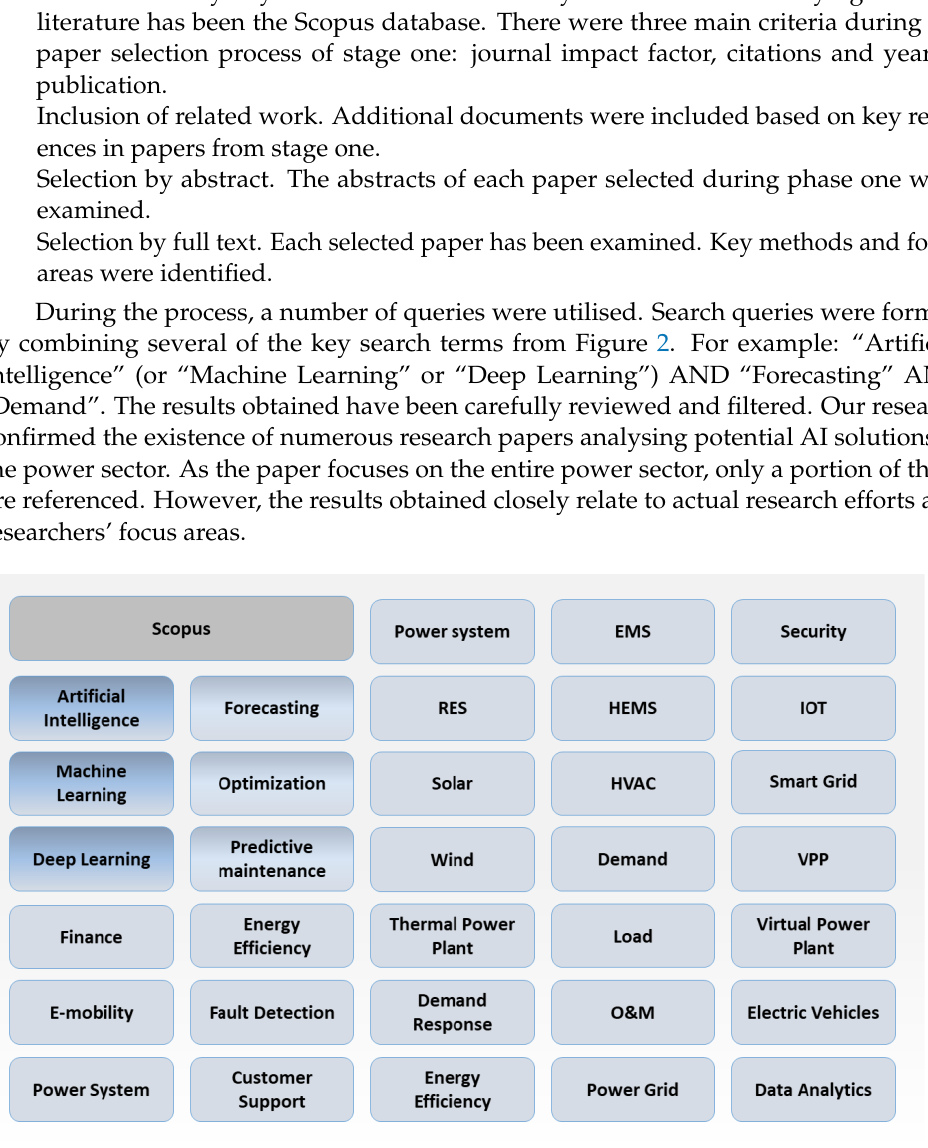
Figure 2. Search methodology and key search terms.